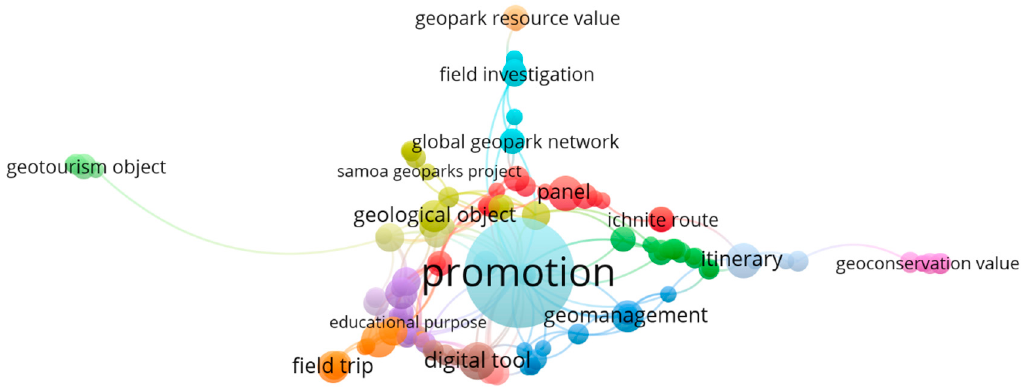
Figure 2. Most used resources that expose the main trends in the promotion of geotourism and geoconservation.